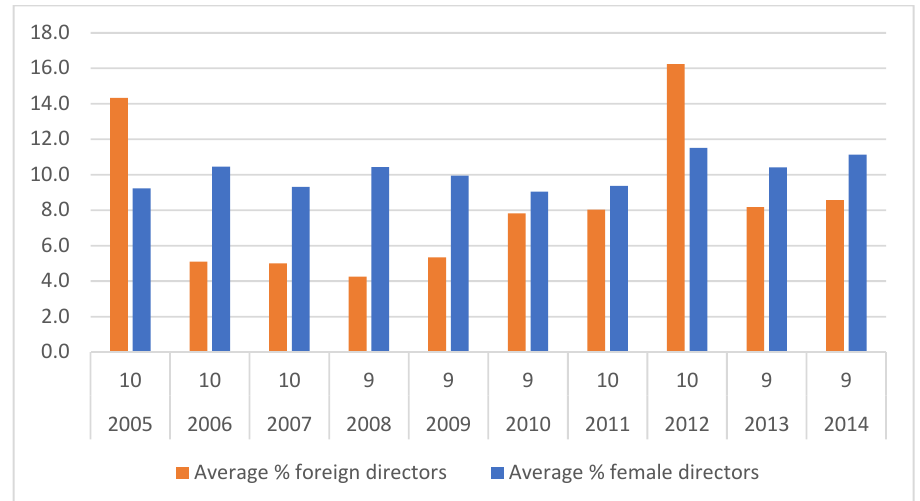
Figure 1. BOD diversity. This figure presents the average board size provided on the primary axis while the average percentage of female directors, and average percentage of foreign directors for the sample companies for 2005 – 2014 provided on the secondary axis.